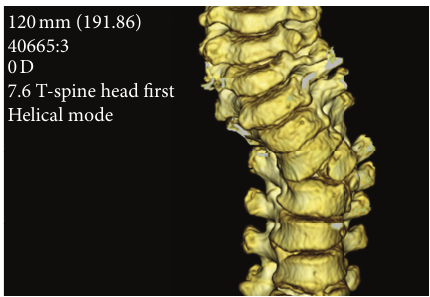
F2:3Dreconstructionillustratingcongenitalscoliosis.LeT4 hemivertebrae displayed. Courtesy of Dr. Kenneth